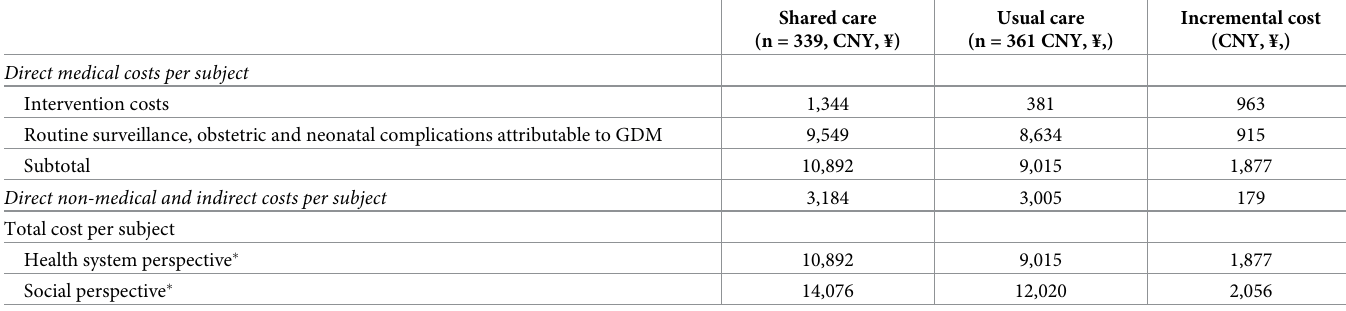
Table 3. Total costs of a lifestyle intervention program for women with gestational diabetes in China, per study participant, by study arm.